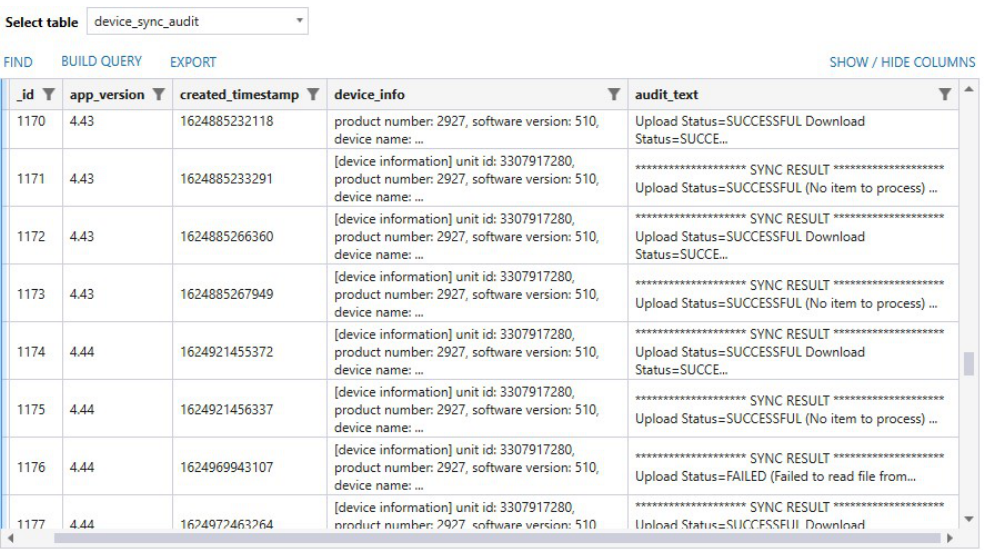
Figure 23. sync timestamps.